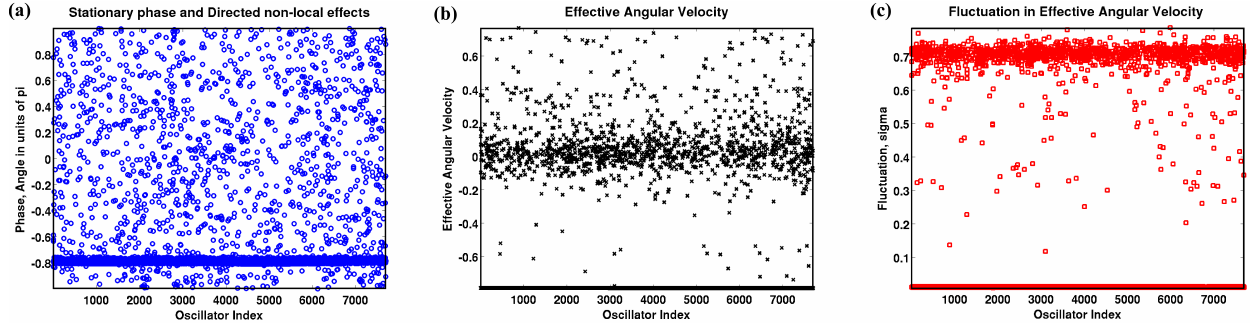
Figure 6. Three attributes of a chimera state of the 7697 oscillators for a 1024 × 1024 gridded map without recurrences using κ = 0.10.